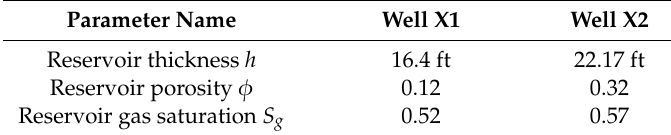
Table 2. Values of reservoir parameters of Well X1 and Well X2.